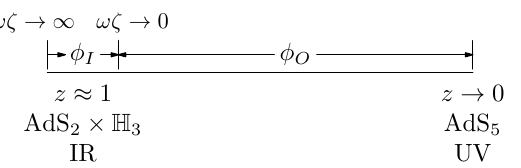
Figure 1 . The inner (near horizon) and outer regions, where the solutions of the Klein-Gordon equation are denoted by φ